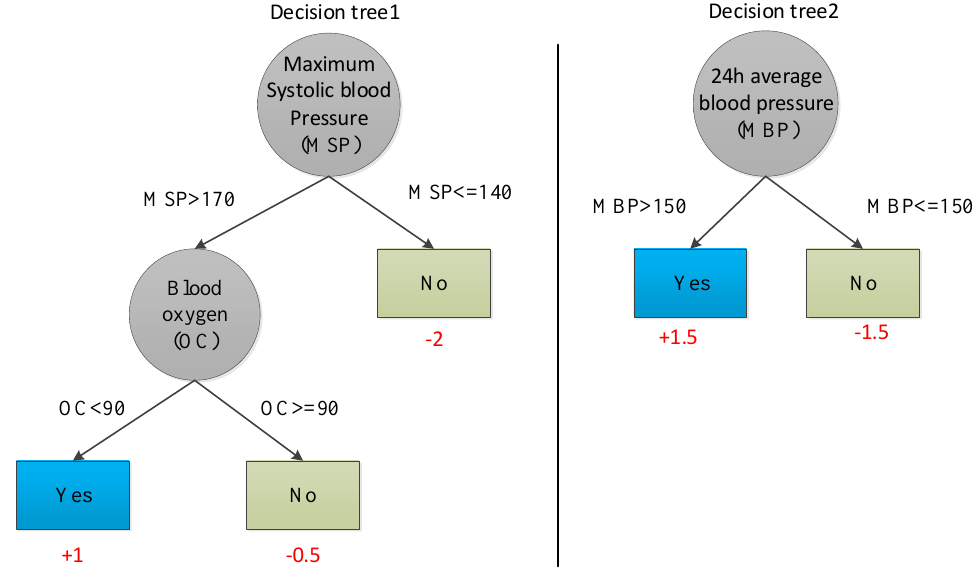
Figure 6. Example of XGBoost-based prediction model.